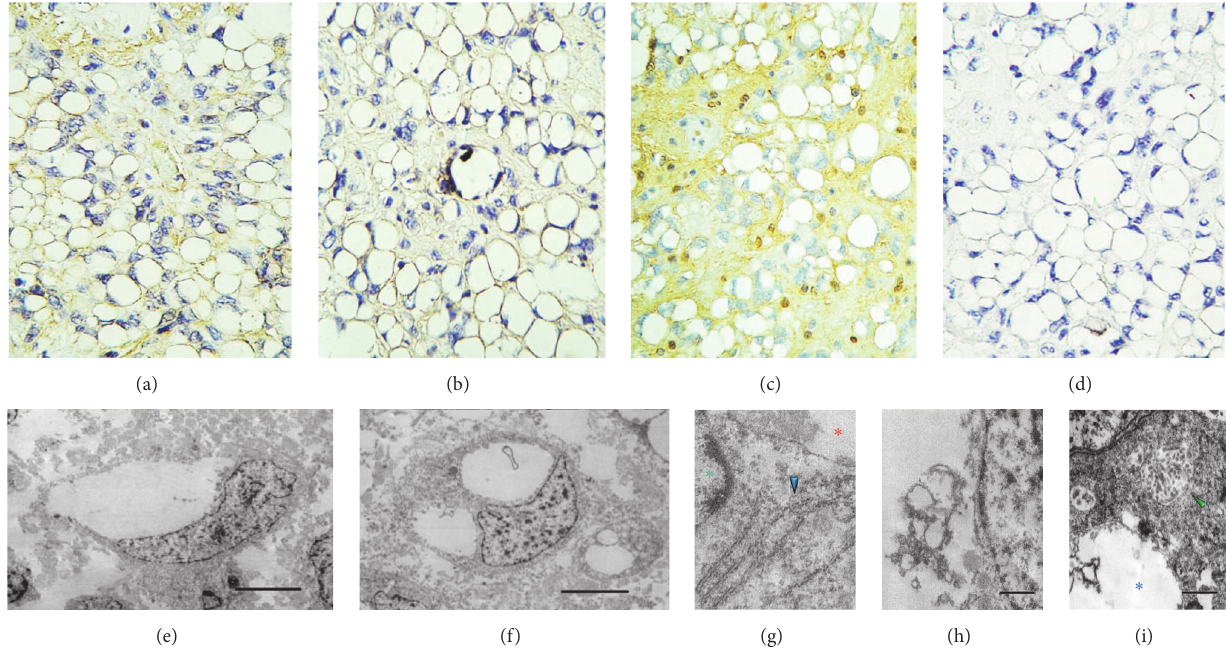
Figure 3: Immunohistochemistry panel/transmission electron microscopy. (a) Glial fibrillary acidic protein (GFAP). (b) CD99. (c) PS100. (d) Ki-67 (MIB-1). (e, f) Uni- and multivacuolated cells featuring void lumina. (g) Rough endoplasmic reticulum (blue arrowhead) near an empty vacuole (orange asterisk). There is no apparent connection between them. On the left side, a small part of the cell’s nucleus can be seen (green asterisk). (h) Hollow intracytoplasmic lumen containing granulofibrillary debris, slightly resembling degenerated microvilli or organelles, next to the nucleus (right field). (i) Microrosette filled with microvilli (green arrowhead) lying close to a dilated vacuole with granulofibrillary material (blue